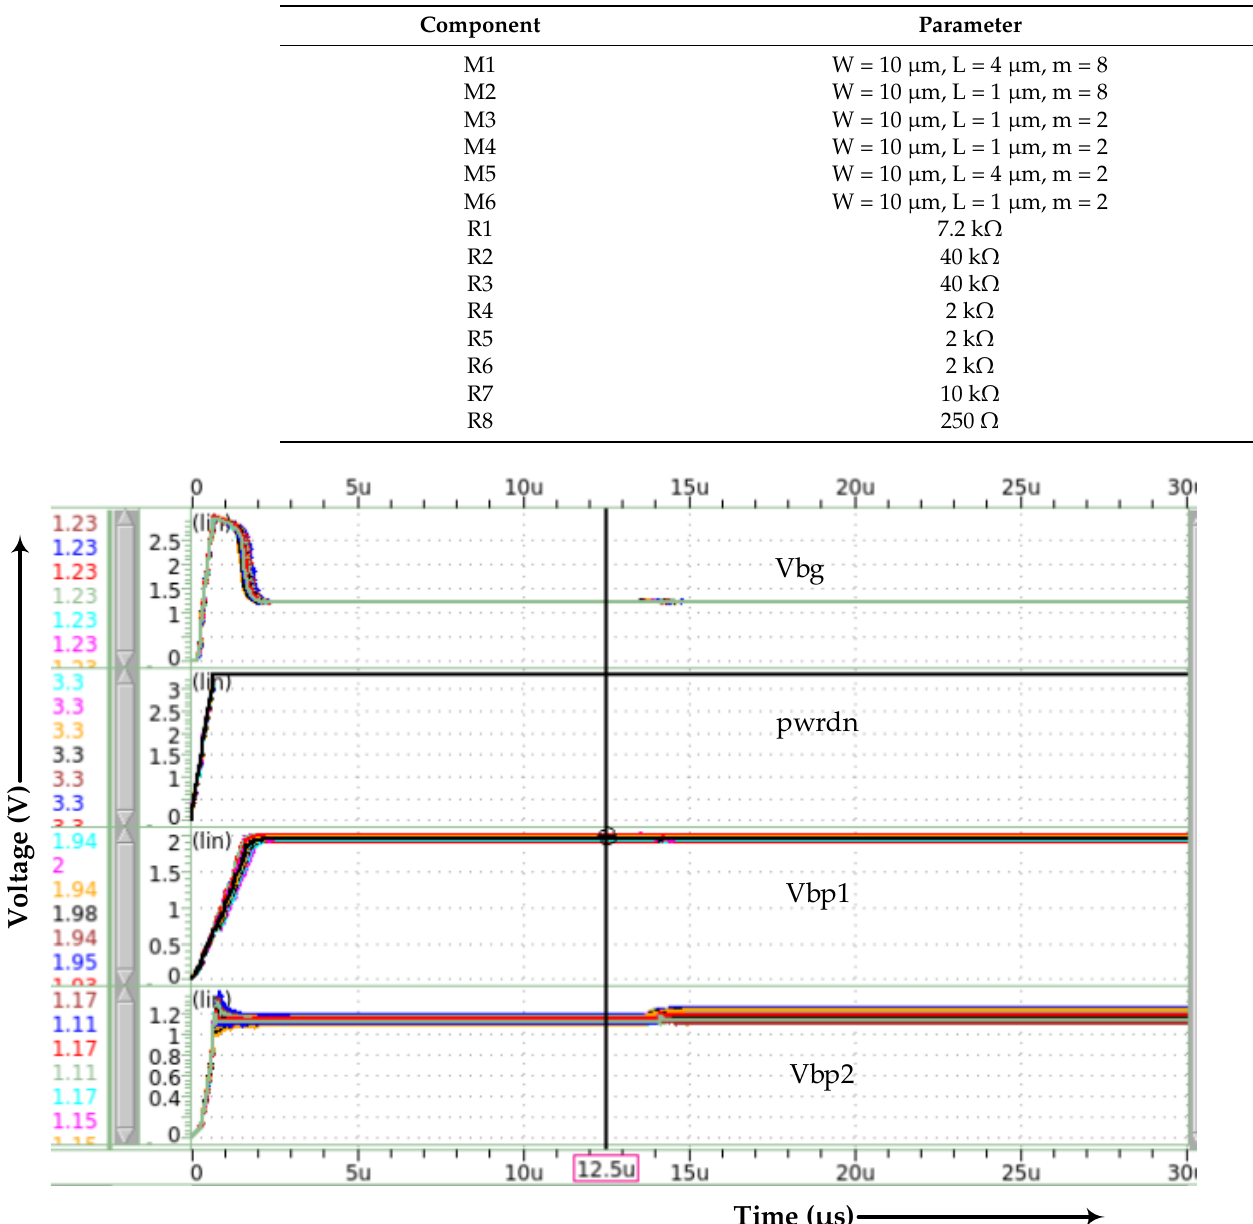
Figure 4. Stabilized BGR output with a startup circuit.